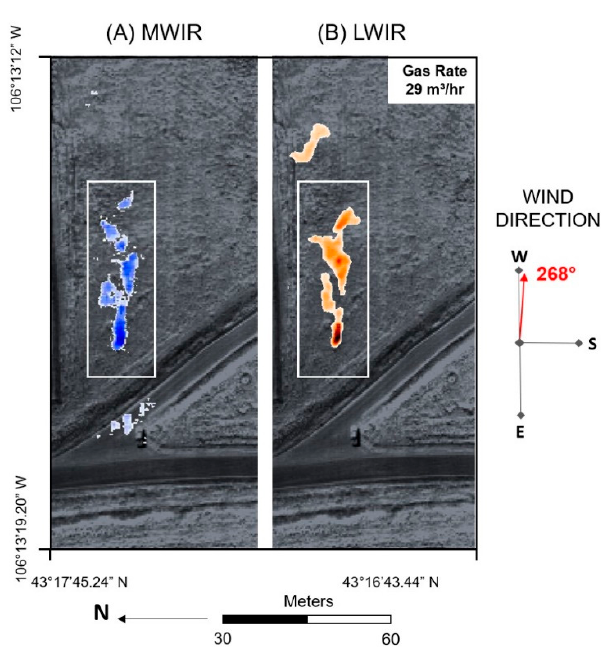
Figure 4. Detection of CH 4 plumes in the ( A ) MWIR and ( B ) LWIR ranges—SEBASS flight performed on 20 August 2010 over station 5 (gas source: RMOTC—injection) at 11:20:26 (local time) with 0.50 m spatial resolution and at 457 m AGL. The red square indicates the ground station location (i.e., source of gas leak) and the respective plume. Pixels in blue ( A ) and red ( B ) indicate the occurrence of methane in the scenes. The main direction of the wind is displayed in the diagram on the right side of the figure (data collected between 11:00 p.m.–12:00 p.m.).